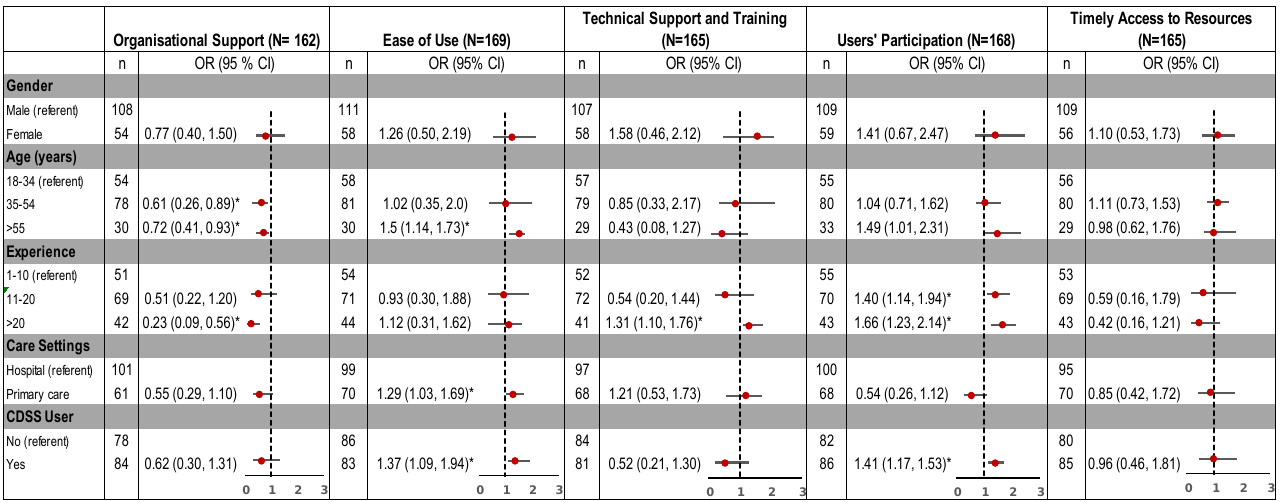
Figure 7. Association of perceived facilitators to CDSS implementation, by demographic characteristics. OR: odds ratio; CI: confidence interval. * Significant predictors as confidence interval does not include 1.0.